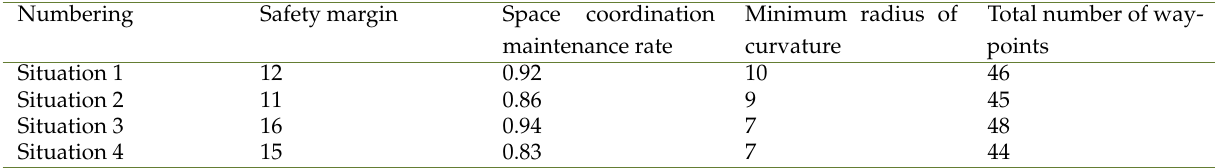
Fig. 4. The distance change between the wall-climbing robot and the drone (a) Case 1, the distance change between the wall-climbing robot and the drone (b) Case 2, The distance change between the wall-climbing robot and the drone (c) Case 3, Figure of distance change between wall-climbing robot and drone (d) Case 4, Figure of distance change between wall-climbing robot and drone Table 1. The formation position relationship is the same, and the track information statistics table of different starting points